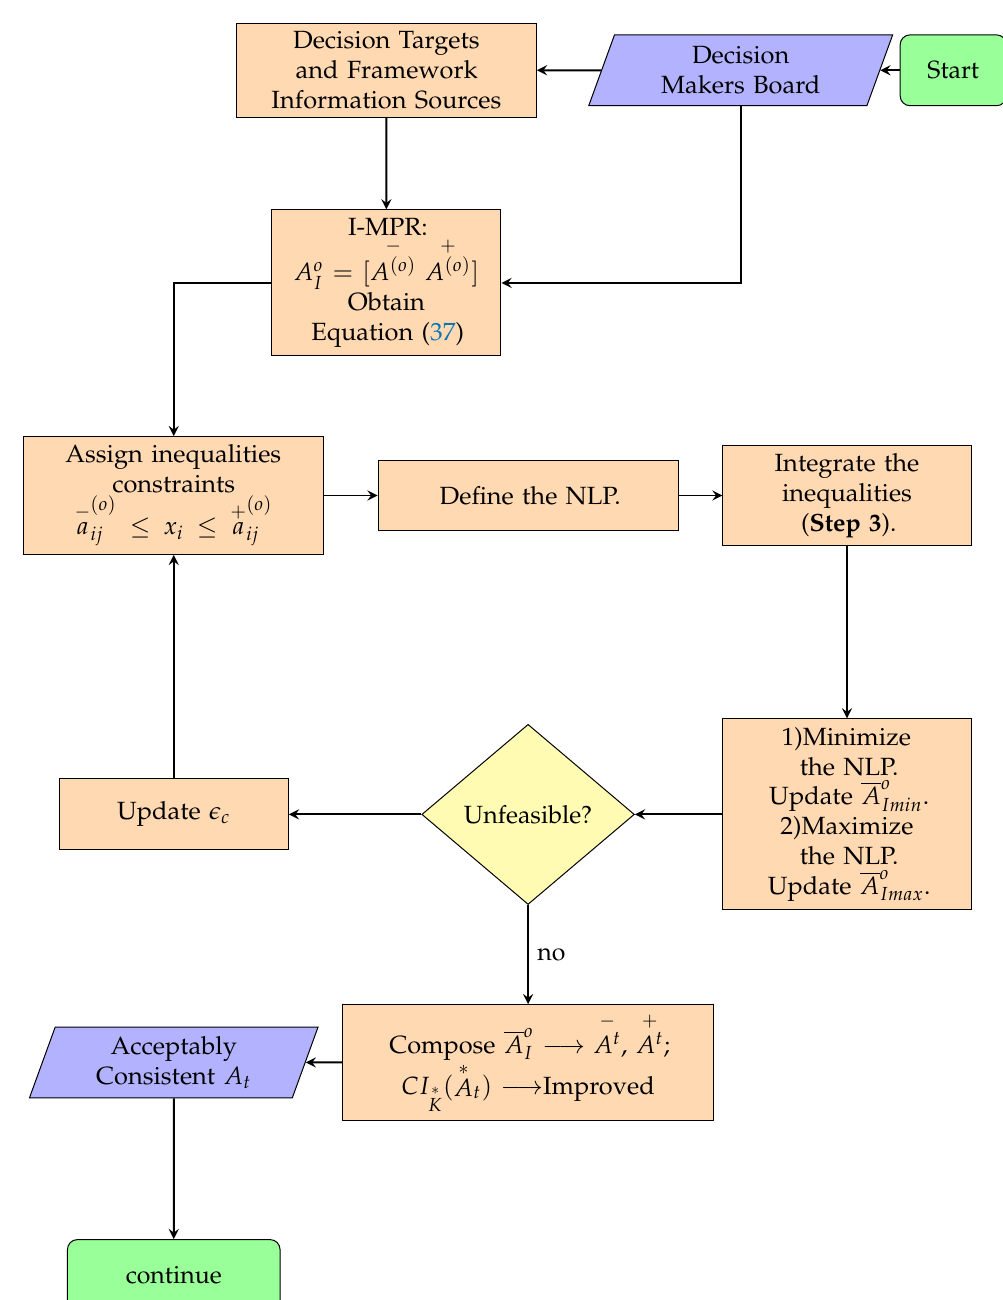
Figure 1. Process flowchart for improving consistency of an